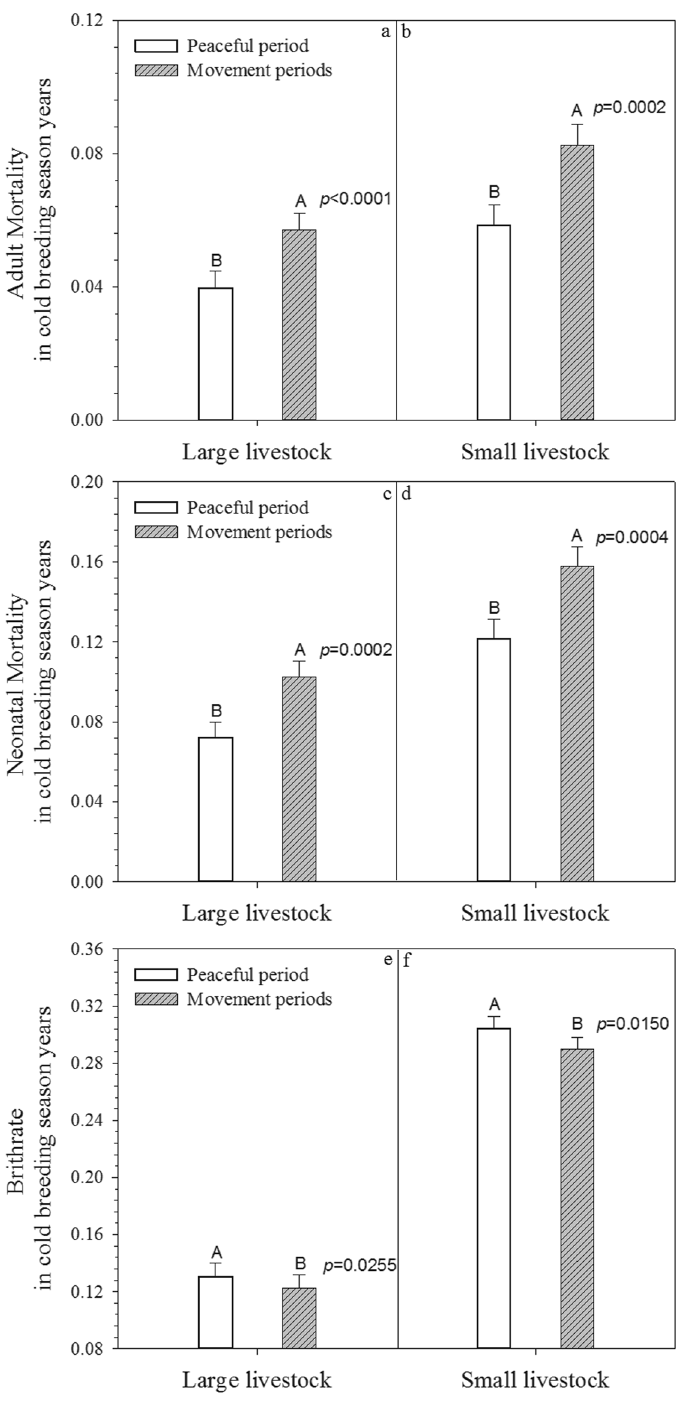
Figure 6. Comparison of Adult, Neonatal Morality and Birthrate in Cold Years during Peaceful and Social Movement Periods. Note: error bars represented standard errors. All population demographic metrics showed significantly differences between peaceful and social movement